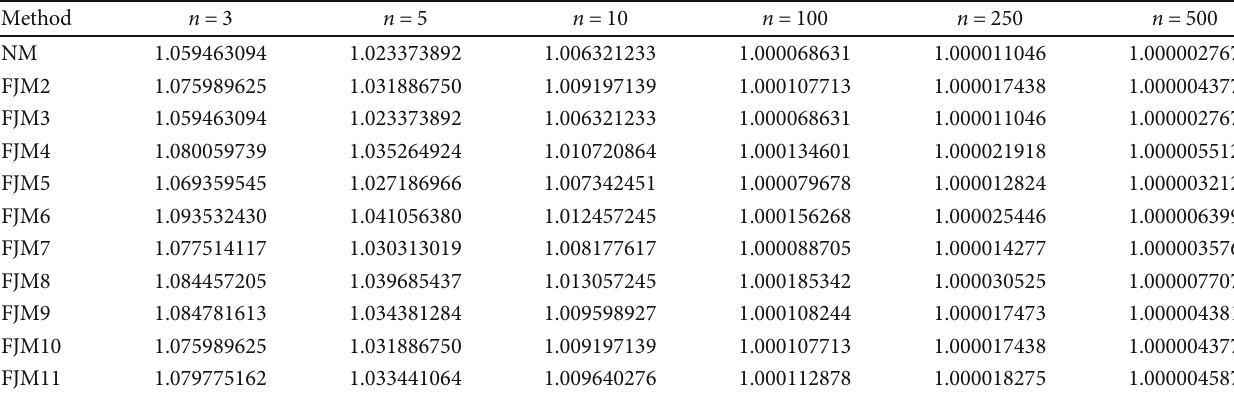
Table 32: Values of I op for the methods in the third category to solve Test Problem 1, and Method